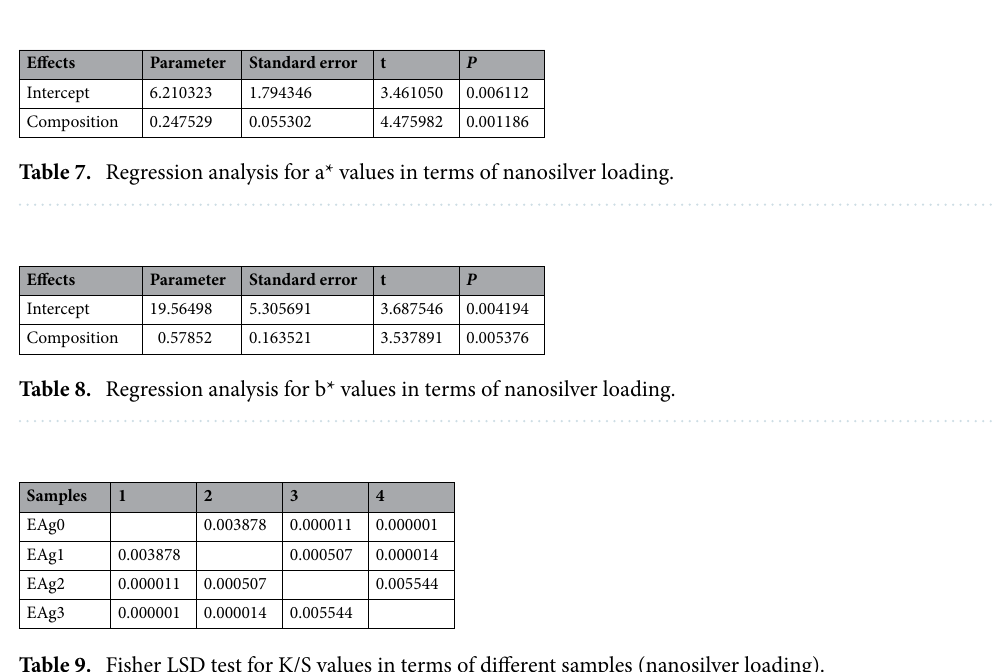
Table 9. Fisher LSD test for K/S values in terms of different samples (nanosilver loading).